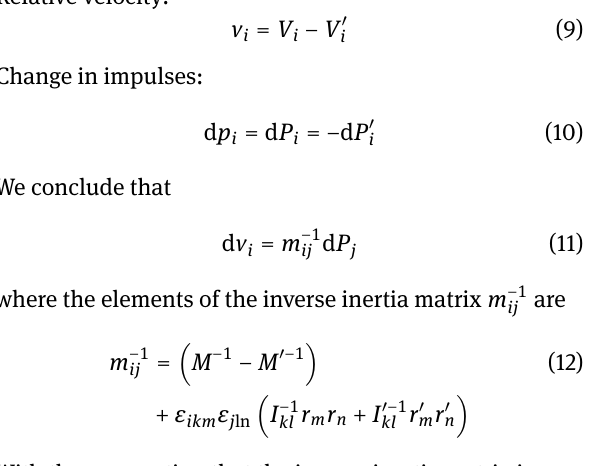
Figure 2. Illustration of collision between two rigid bodies [17]. Figure 2: Illustration of collision between two rigid bodies [17]